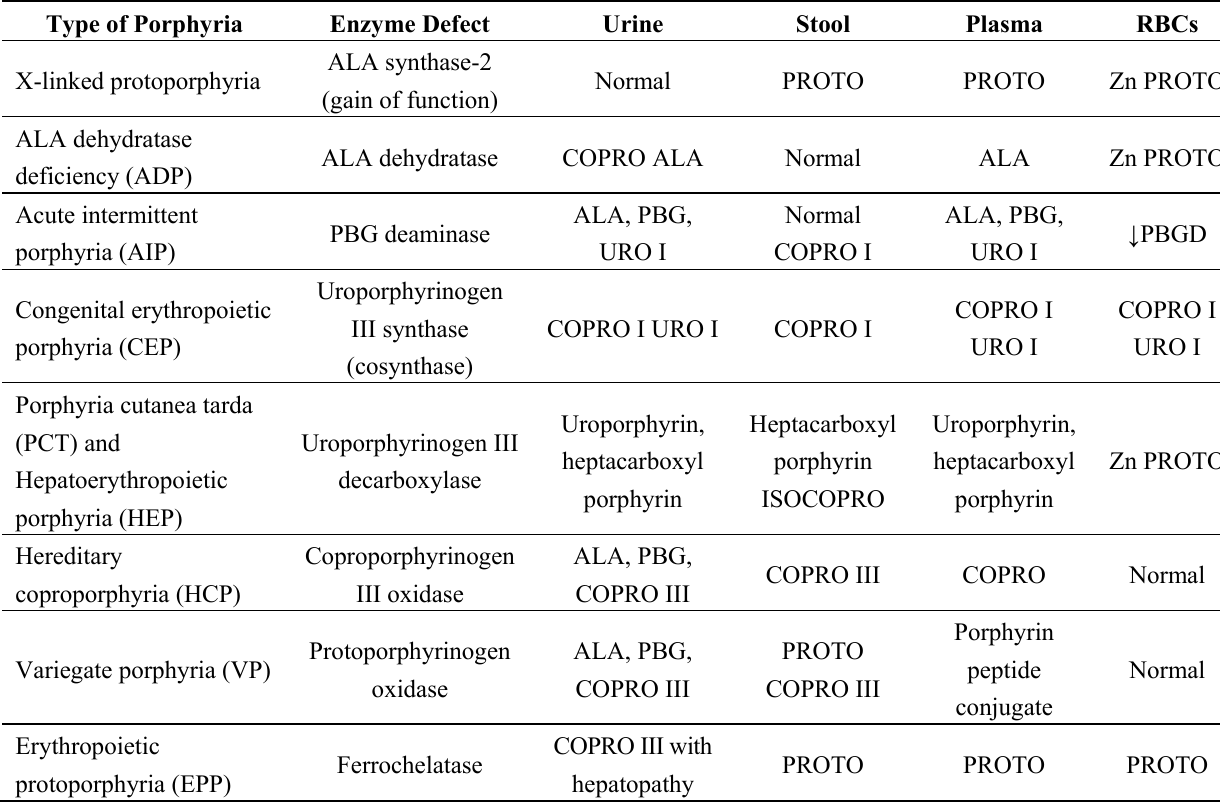
Table 5. Enzymatic defects and major biochemical abnormalities in porphyrias. Only major increases in urine, stool, plasma and erythrocytes (RBCs) are